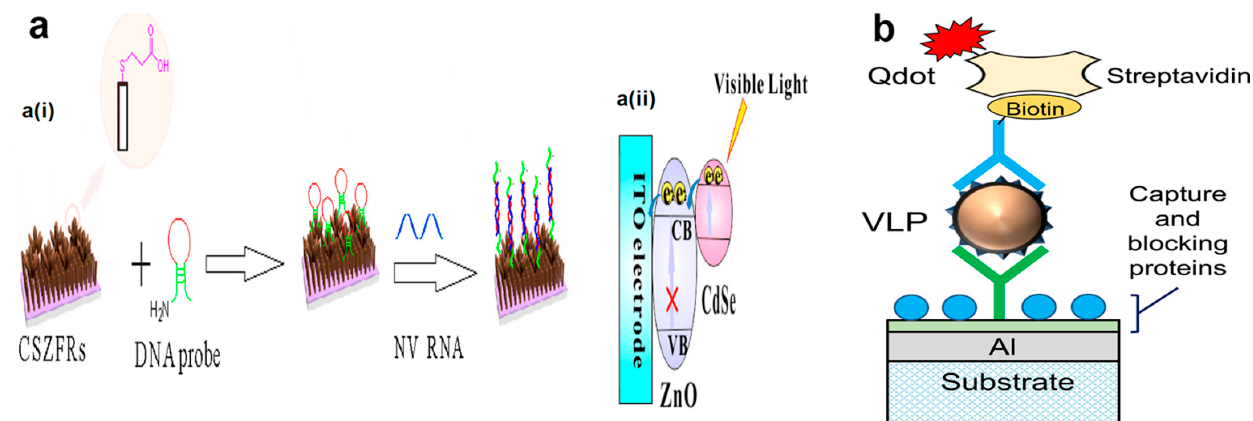
Figure 6. ( a ) A schematic presentation of ( a ( i )) the synthesis procedure and ( a ( ii )) electron transfer of CdSe–ZnO flower-rod core-shell structure (CSZFRs)-based photoelectrochemical (PEC) biosensor. ( b ) Schematic illustration of the surface of the V-trenches designed for detection of norovirus virus-like particle (VLP). The figures were reprinted with permission from refs. [148,149], Copyright 2018, Multidisciplinary Digital Publishing Institute (MDPI) and copyright 2017, Elsevier, respectively.